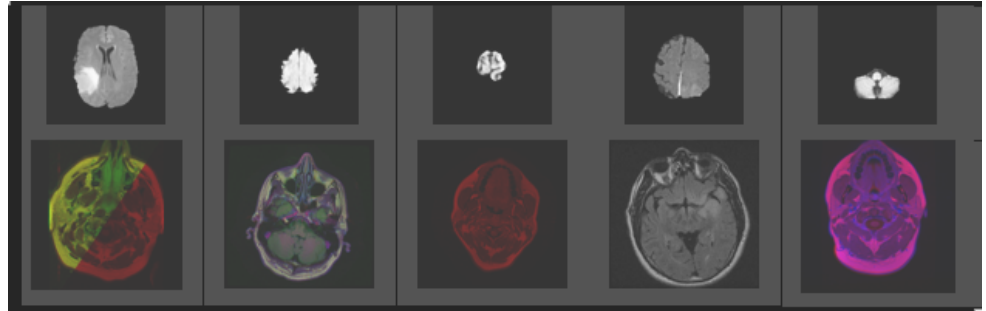
Figure 10. Sample images of Kaggle brain tumor